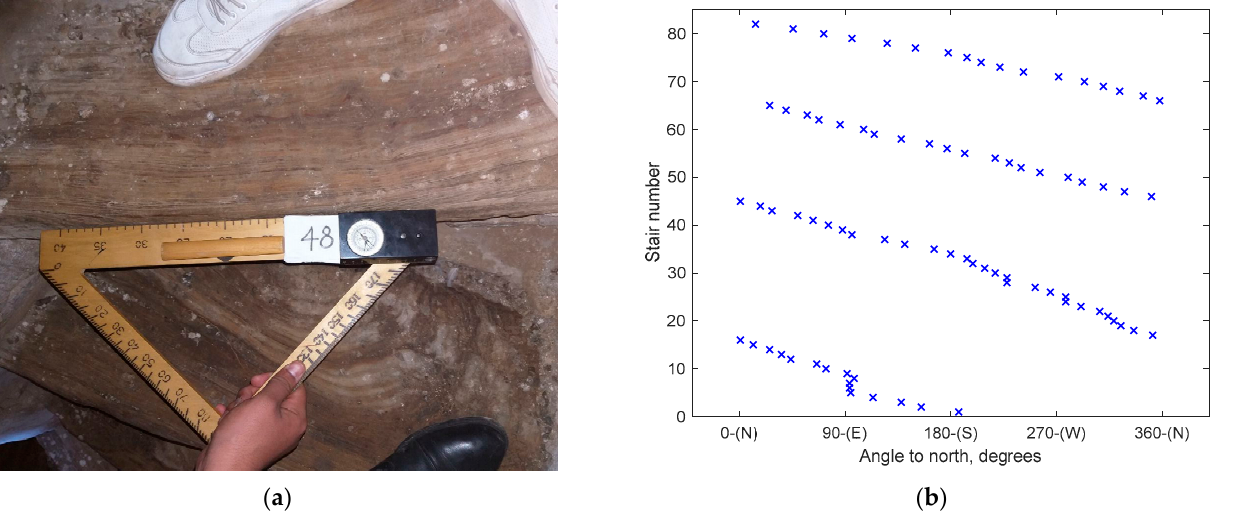
Figure 8. Measurements of each stair’s orientation: ( a ) typical measurement (stair no. 48 is shown); ( b ) angles of all stairs.